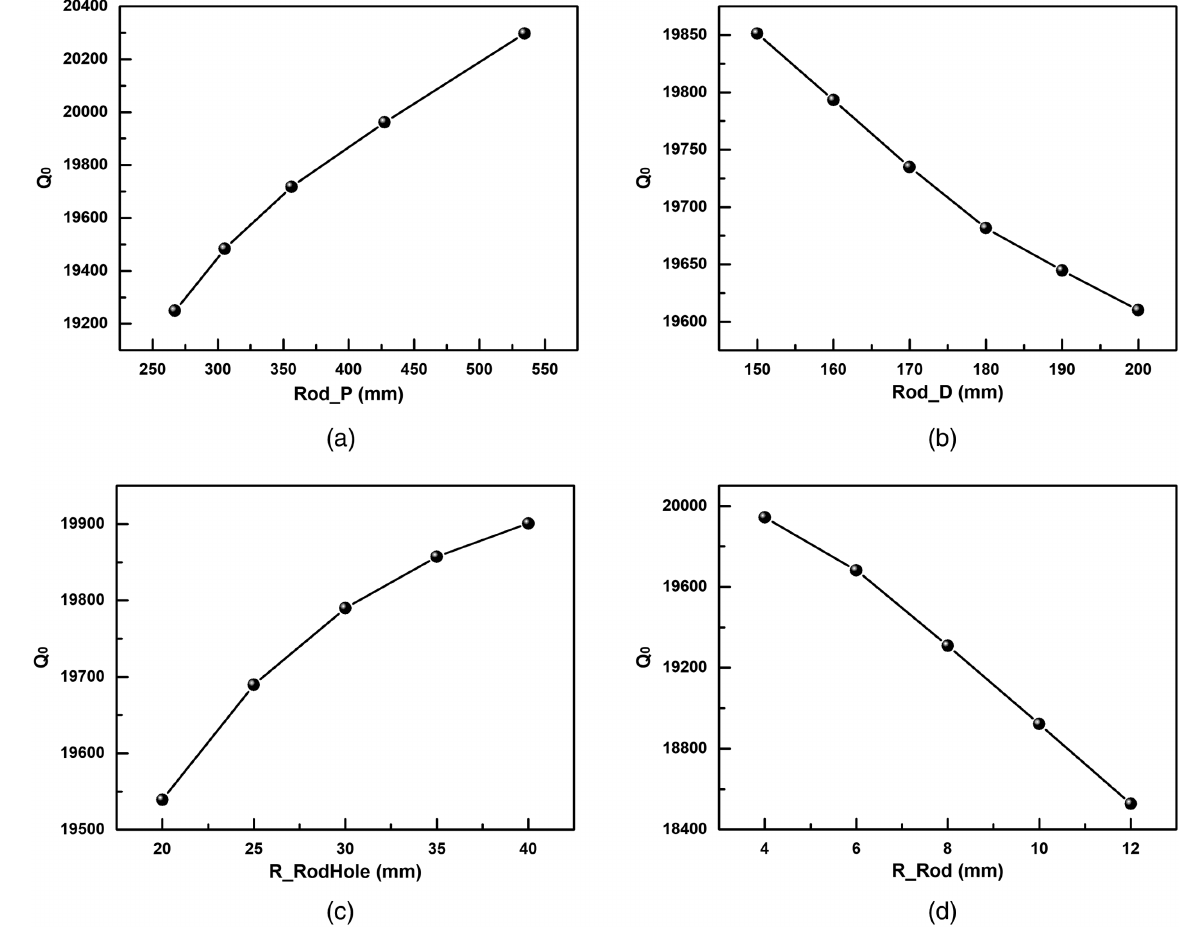
FIG. 10. Effects of PISL geometry [(a) rods period Rod_P; (b) rods distance Rod_D; (c) holes radius R_RodHole; (d) rods radius R_rod] on cavity quality factor Q 0 .